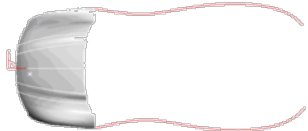
Figure 2. Part of a car model.